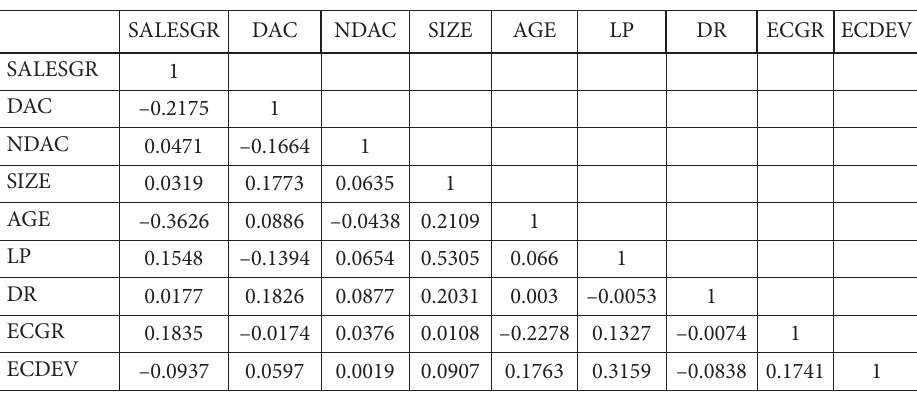
Table 3. Correlation